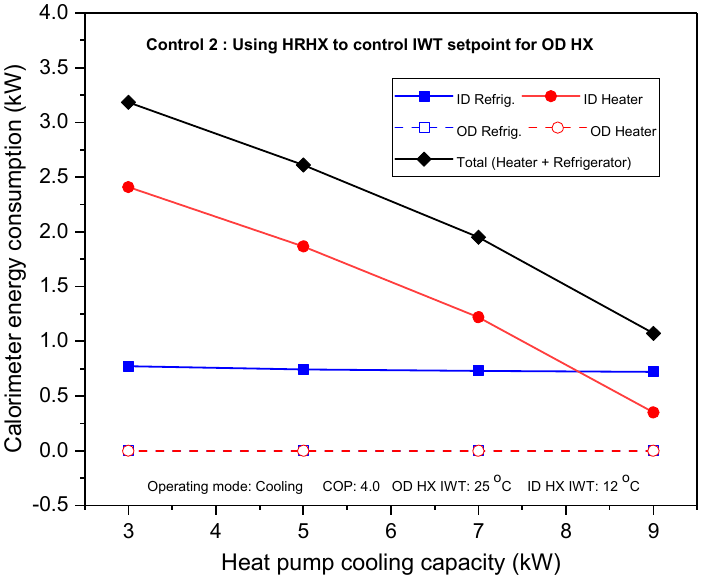
Figure 13. Calorimeter energy consumption with variation in heat pump cooling capacity for control (2). Table 4. Energy consumption data for a conventional calorimeter and the proposed calorimeter with heat recovery unit in cooling mode.